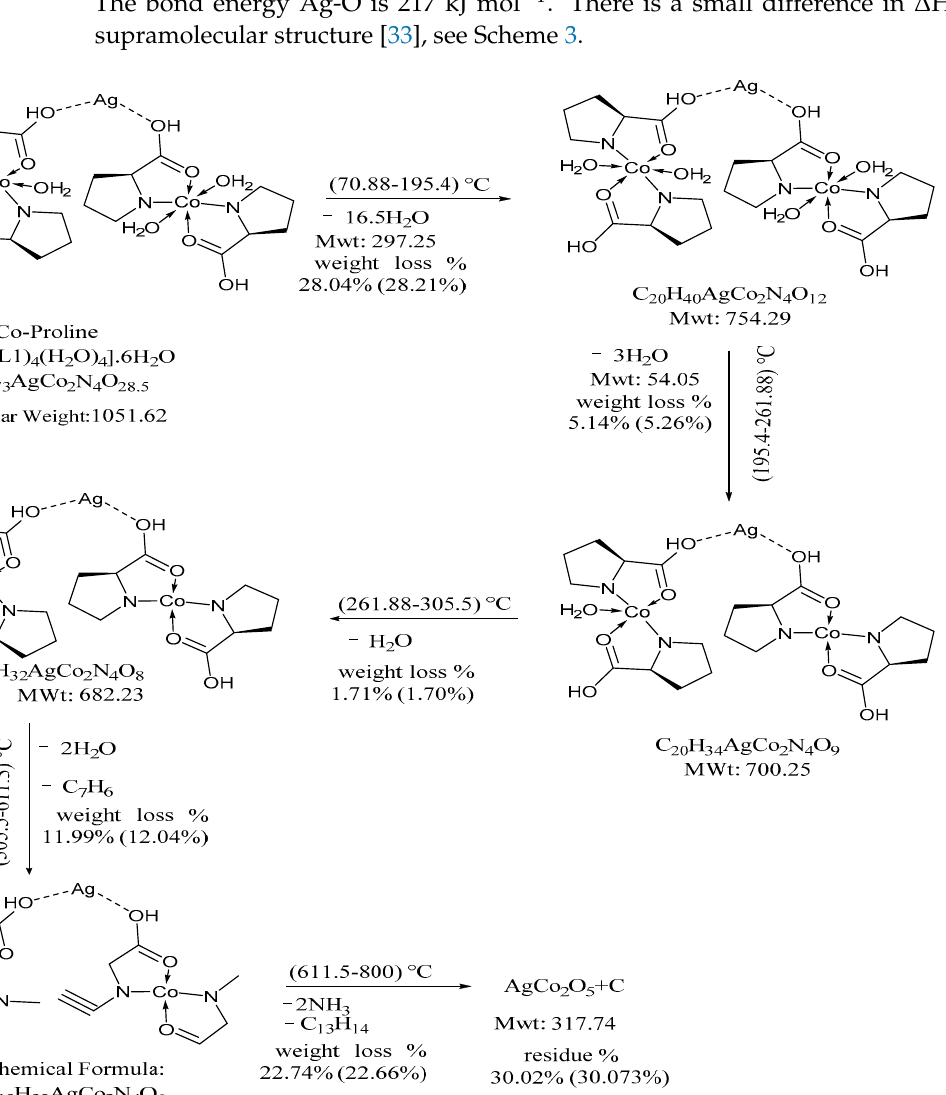
Scheme 3. Thermal degradation of PCCAg 0 NPs. Co(II) ion is a covalently linked proline through nitrogen or oxygen atom. Doping proline CoCl 2 crystal by Ag 0 NPs gives thermally stable self-assembled crystals. Ag 0 NPs is an inorganic linker. Thermal parameters and activation parameters, Ea, Δ